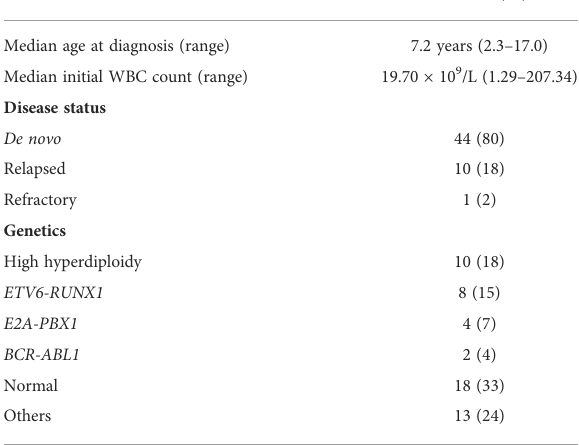
TABLE 1 Patient